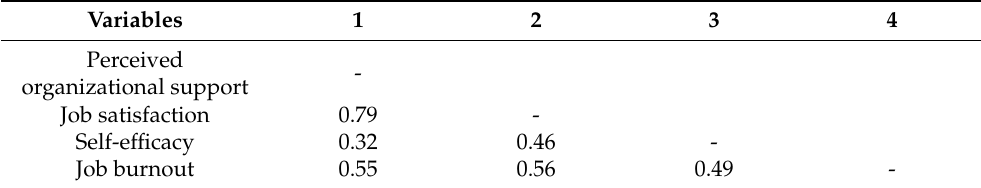
Table 6. Heterotrait–monotrait (HTMT) discrimination validity of the measurement model.